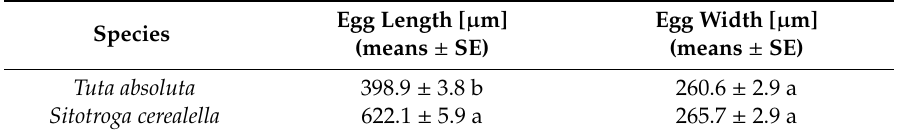
Table 5. Average egg lengths and widths of the target host T. absoluta and the rearing host S. cerealella . Arithmetic means ± SE are calculated from 20 measured eggs for each host species. Di ff erent letters within a column indicate significant di ff erences among means ( t -test, p < 0.05, n = 20).